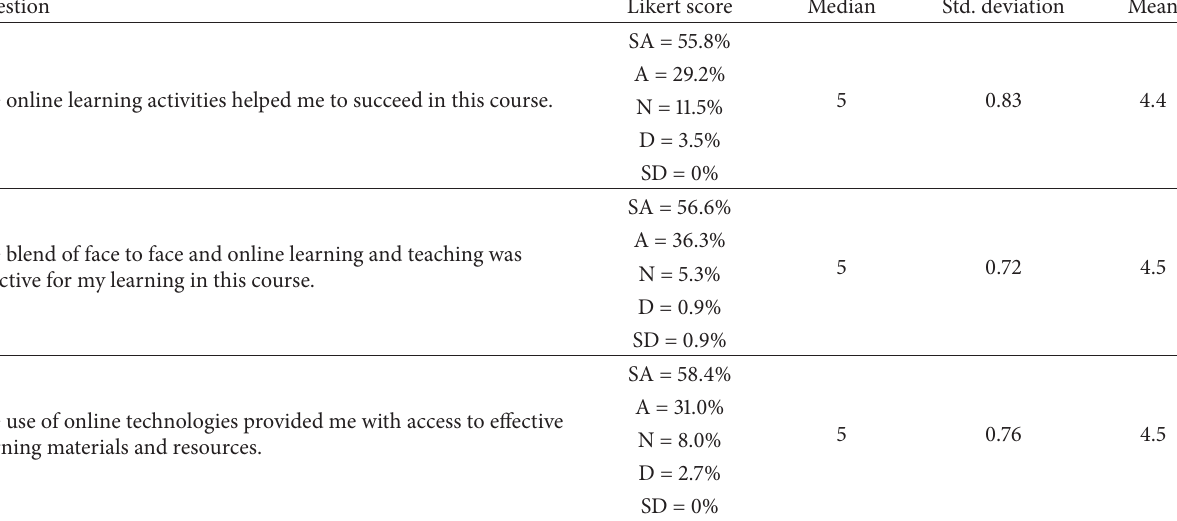
Table 4: Showing a summary of the results of the additional SEC questions related to the online resources developed in conjunction with the flipped classroom, ( 𝑛 = 84 in 2014; 𝑛 = 113 in